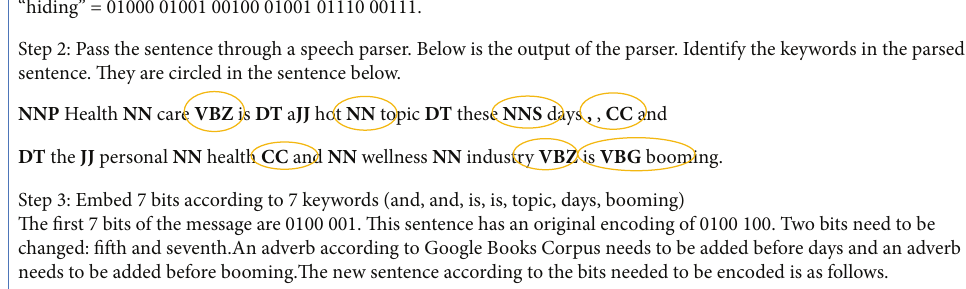
Figure 3: An example of a sentence being